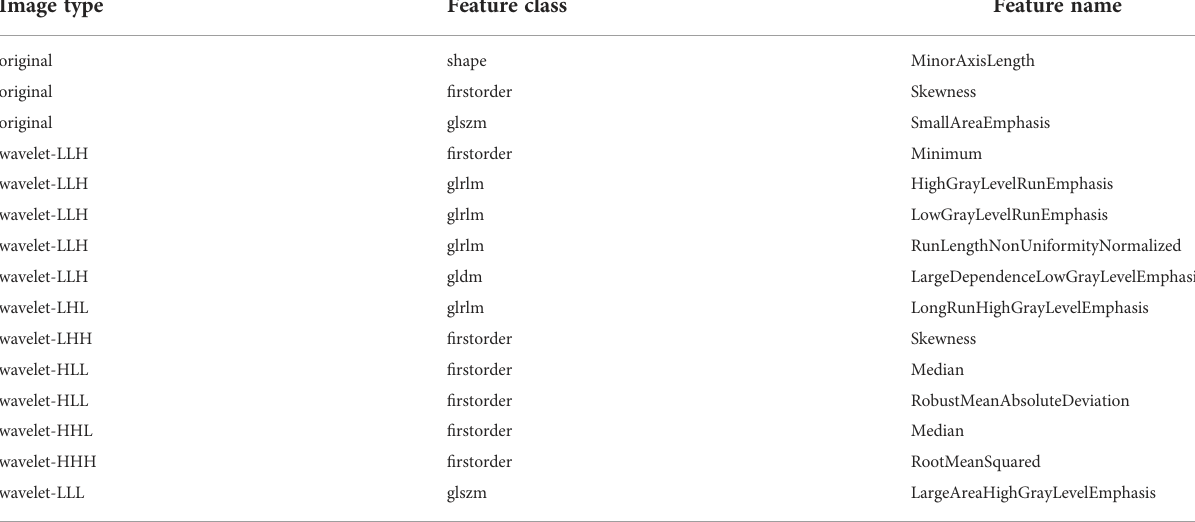
TABLE 2 List of the selected features with non-zero coef fi cients.